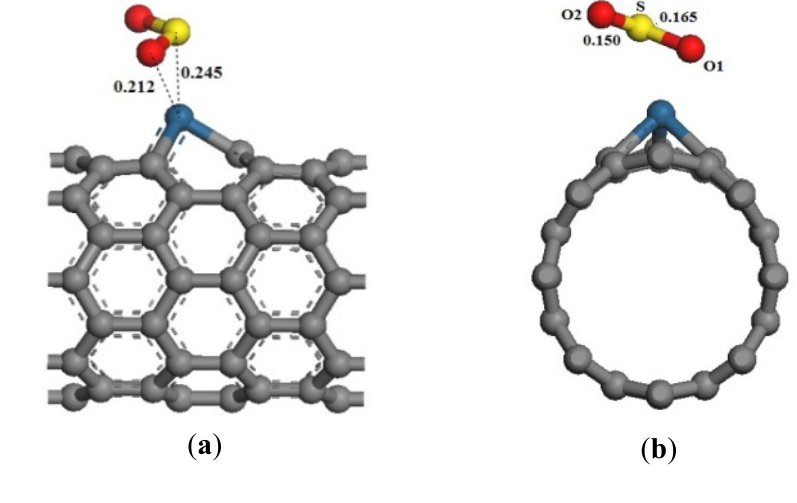
Figure 2. Structural model of the SO ( b ) side